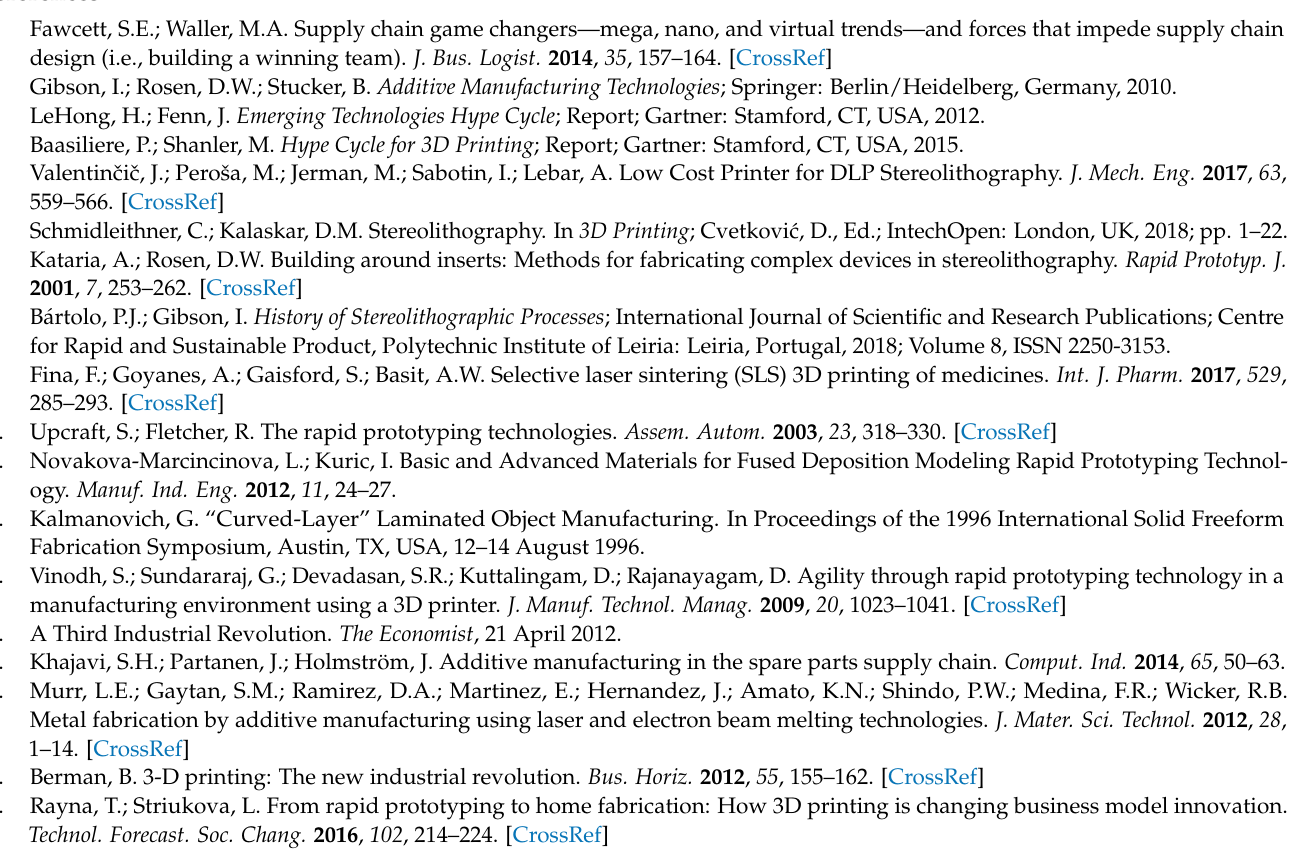
Figure S7 : Correction of the protective helmet band for the head size of a particular user, Figure S8: The technological team dealing with the study of the production process of the protective